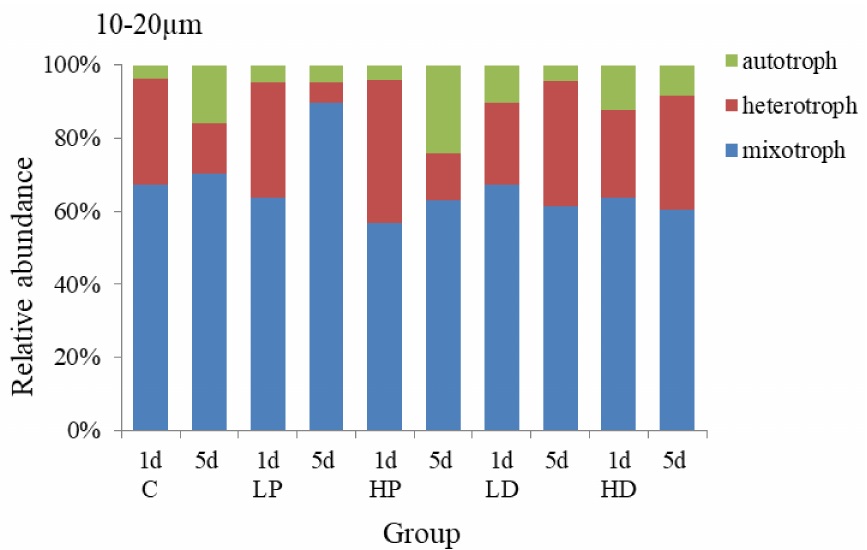
Figure 5. Variation in the trophic structure of protists in 10–20 µ m